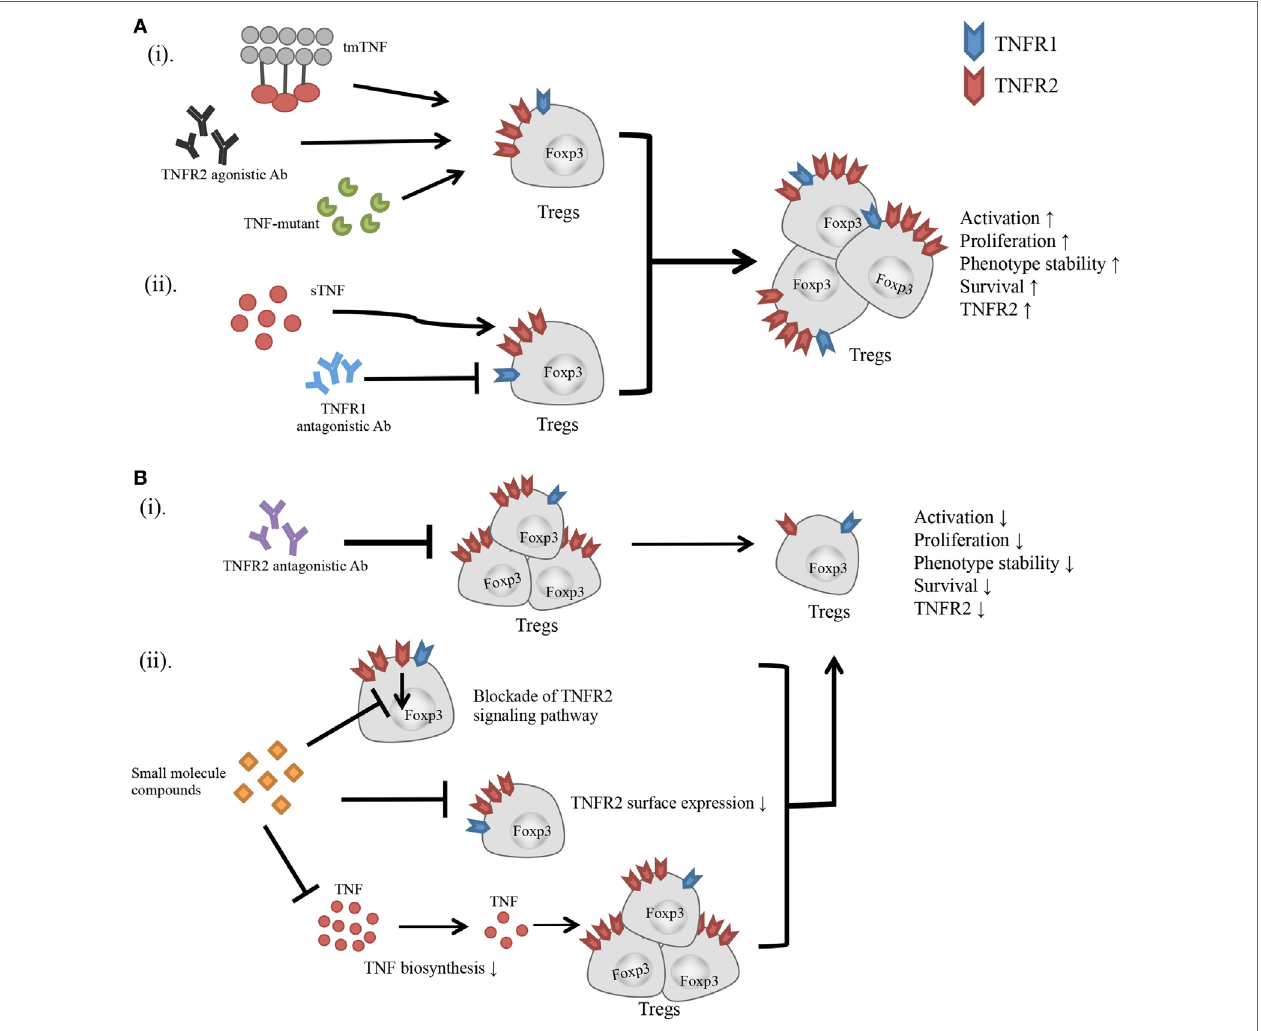
FiGURe 1 | Effect of TNFR2-targeting agents on the activity of Tregs. (A) (i) Transmembrane TNF, TNFR2 agonistic Ab, and TNF mutant preferentially bind to and stimulate TNFR2. (ii) Blockade of TNFR1 with antagonistic Ab diverts the stimulatory effect of TNF to TNFR2. All these agents have potential to activate Tregs, and promote the proliferative expansion, phenotypic stability, survival, and TNFR2 expression on Tregs. (b) (i) TNFR2 antagonistic Ab blocks TNF–TNFR2 interaction. (ii) Small molecule compounds with the capacity to inhibit TNFR2 signaling pathway, or downregulate TNFR2 surface expression, or suppress TNF biosynthesis. These agents may inhibit the activation and proliferation of Tregs, and reduce the phenotypic stability, survival, and surface TNFR2 expression on